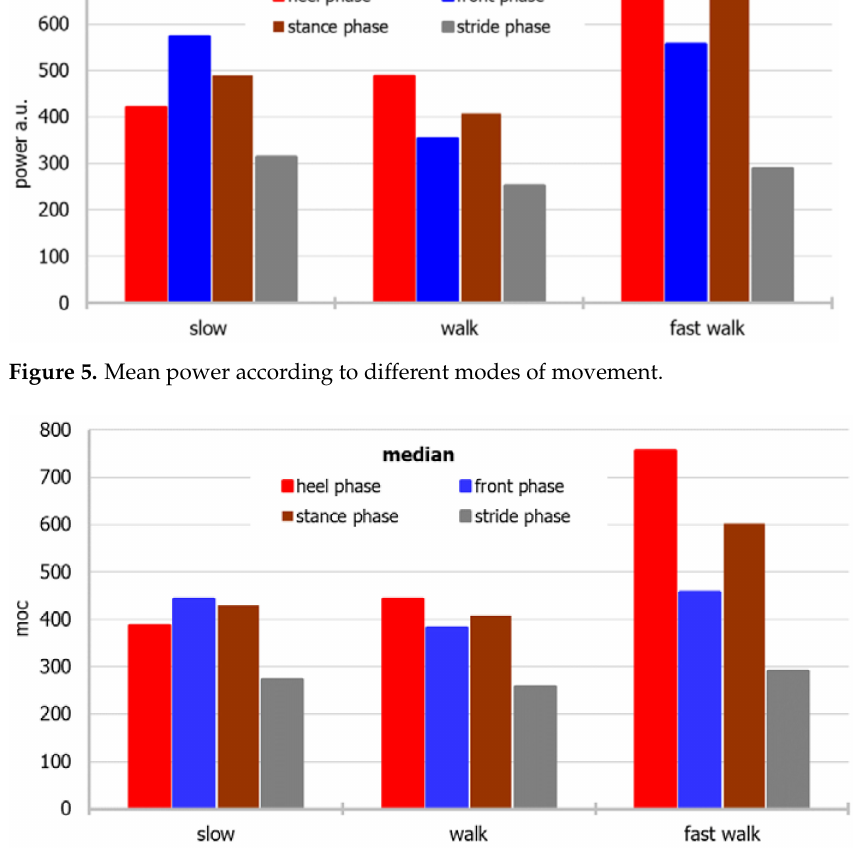
Figure 6. Median power according to different modes of